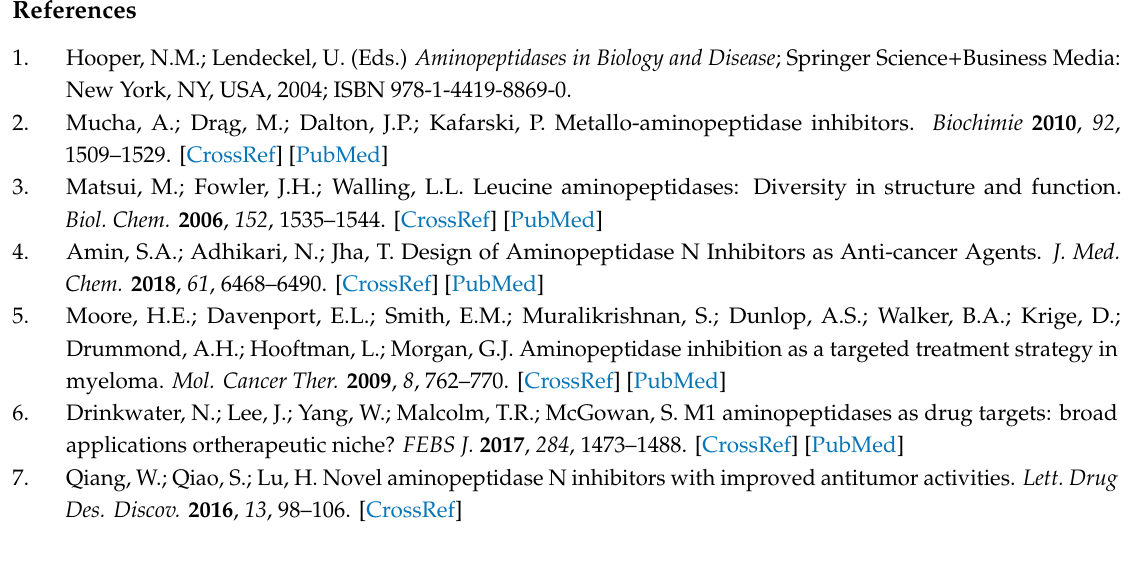
Supplementary Materials: The following are available online at http: // www.mdpi.com / 1424-8247 / 12 / 3 / 139 / s1. Tables S1 and S2: Interactions of both isomers of compounds 1–14 with amino acids of porcine aminopeptidase (pAPN) taken for refinement during the IFD, Tables S3 and S4: Interactions of both isomers of compounds 1–14 with amino acids of bovine lens lerucine aminopeptidase (pAPN) taken for refinement during the IFD, Tables S5 and S6: Interactions of both isomers of compounds 1–14 with amino acids of tomato acidic lerucine aminopeptidase (pAPN) taken for refinement during the IFD, Table S7: The kinetic parameters characterizing activity of the isolated aminopeptidase from barley seeds, Enzyme assays procedure; PlotS1: Graphical determination of the KM value for aminopeptidase from barley seeds by using Lineweaver-Burk: unweighted (blue line) and weighted (red line) regression method and PlotS2: Graphical determination of the KM value for aminopeptidase from barley seeds by using Michaelis-Menten: unweighted (blue line) and weighted (red line) non-linear regression